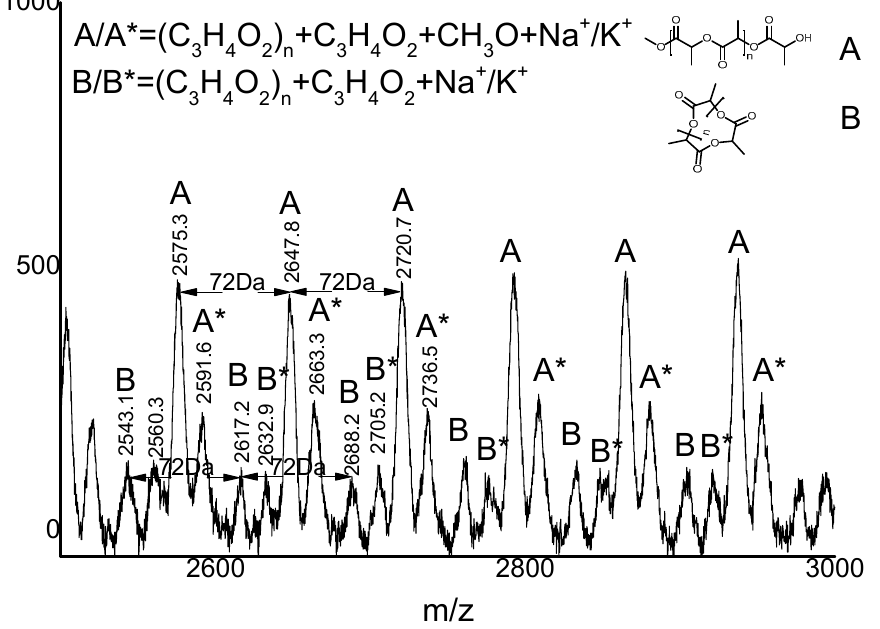
Figure 3. MALDI-TOF spectrum of polylactide prepared by the ROP of L -LA (run 6, Table 2).